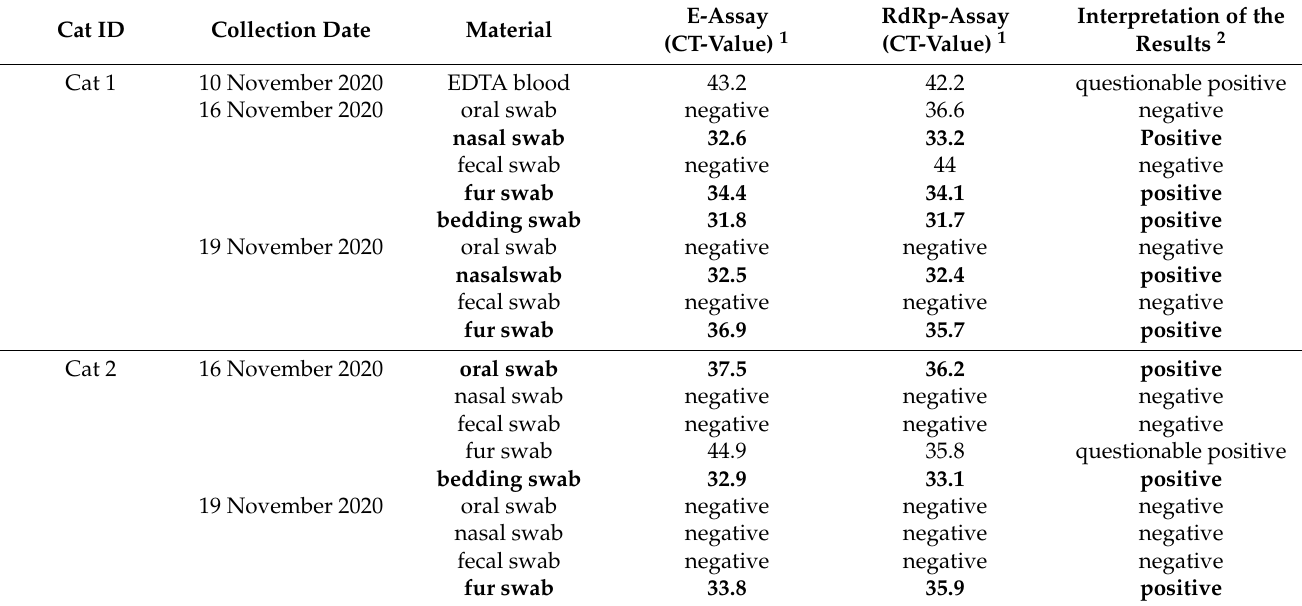
1 Displayed cycle threshold (CT) values indicate measurements in neat samples except for the oral swab from Cat 2 (dilution 1:5) collected on 16 November 2020. 2 Interpretation: positive: CT-values ≤ 38 in both assays; questionable positive: CT-values between >38 and <45 in one or both assays; and negative: CT-values ≥ 45 in one or both